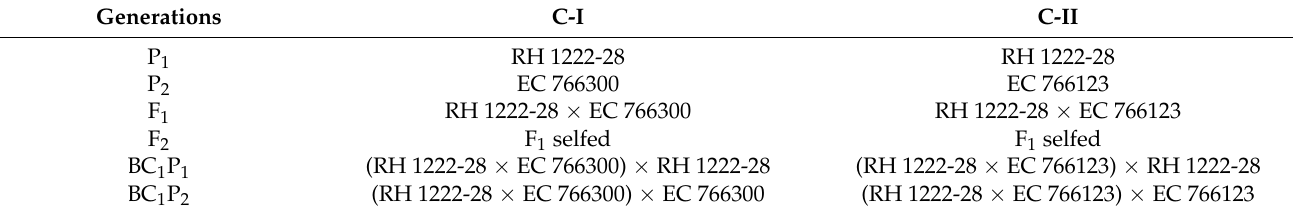
Description of six generations of two crosses, viz., C-1 (RH 1222-28 × EC 766300) and C-II (RH 1222-28 × EC